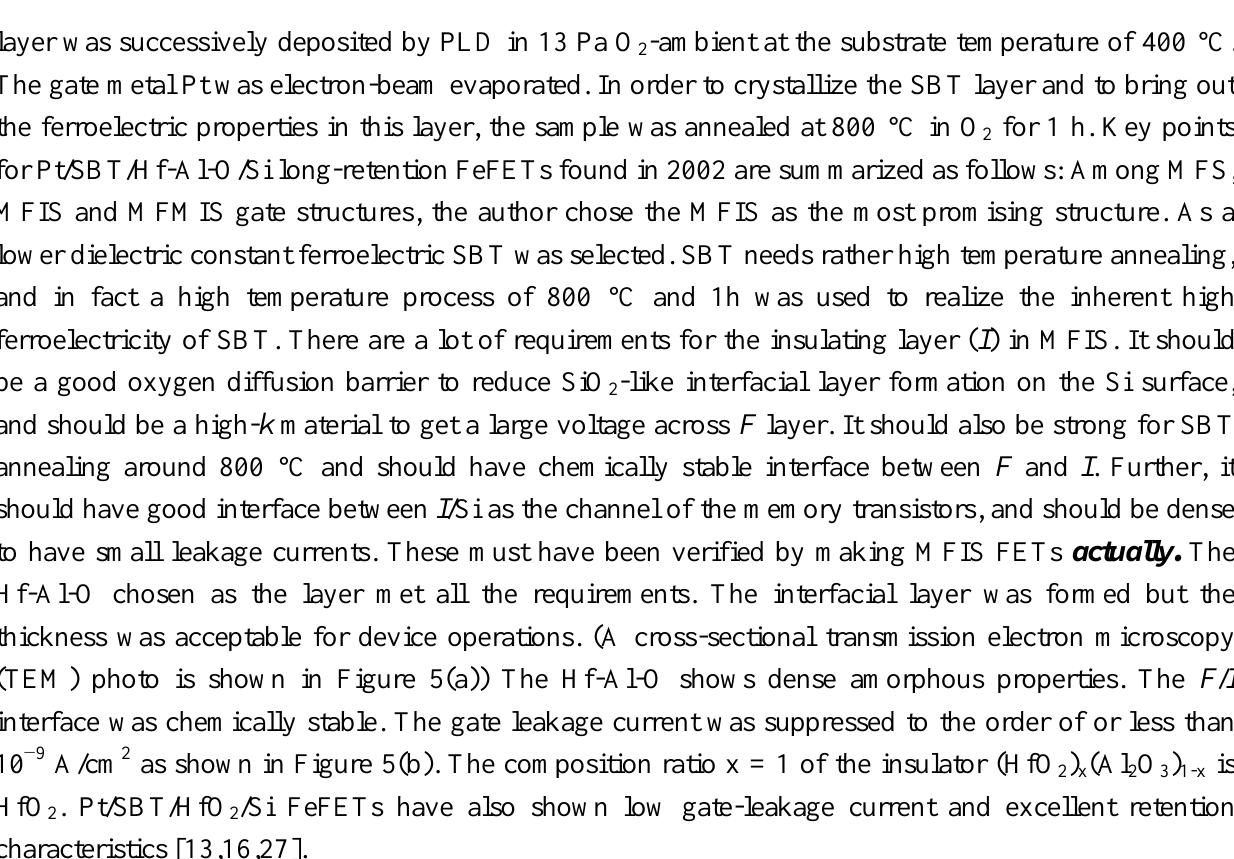
Figure 5. (a) Cross-sectional view of a gate by TEM, reprinted from reference [17] with permission of the Japan Society of Applied Physics, and (b) a gate-leakage property